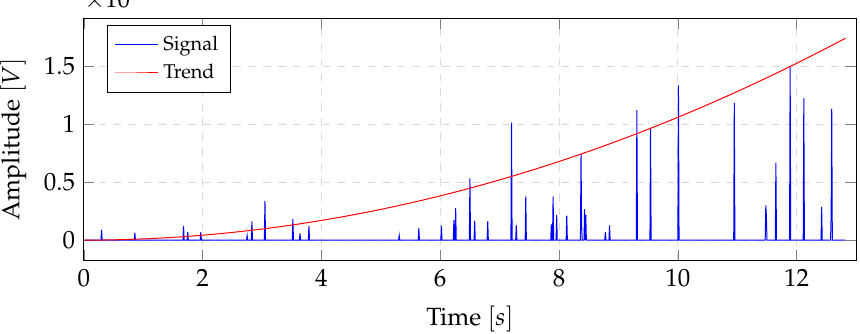
Figure 5. Example of peaks forming a characteristic